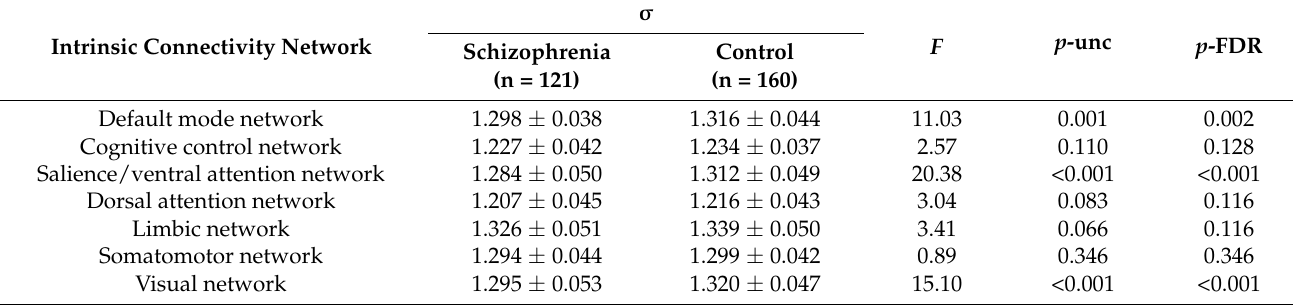
Table 2. Results from the group comparison of network’s small-worldness metric at the intrinsic connectivity network-level local scale